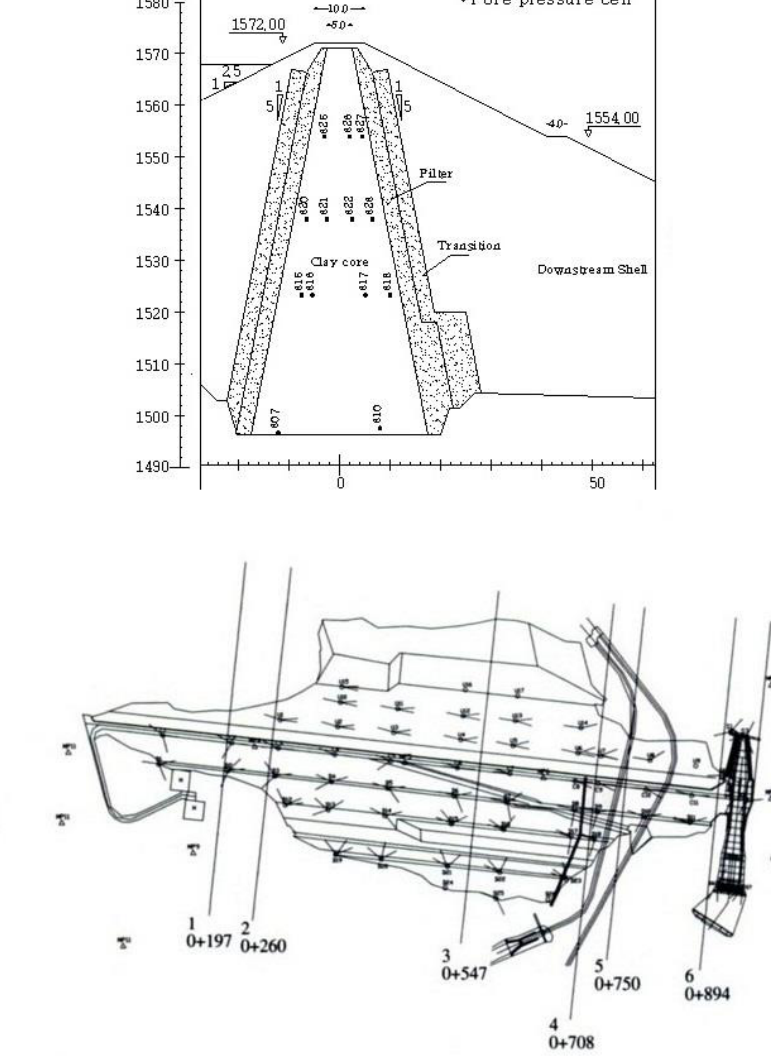
Figure 11. The location of the instrumentations on the studied dam.